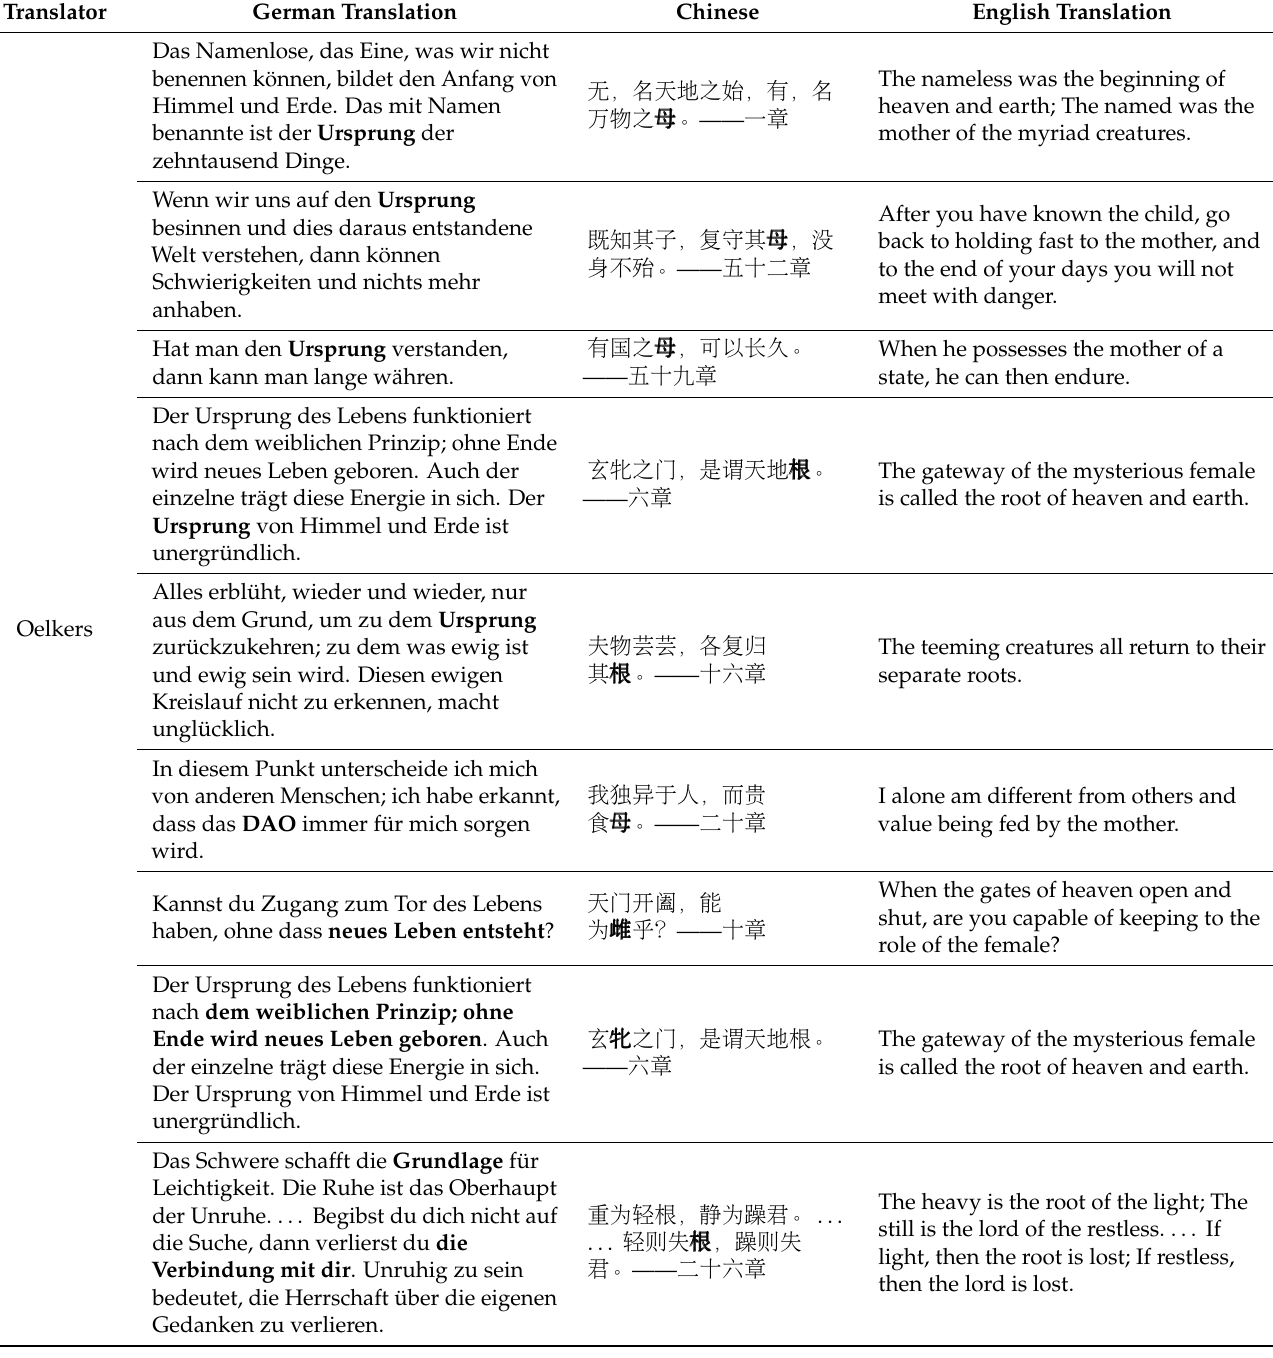
Table 6. The Total Concealment of Xi à ng in the German Translation of the D à o D é J¯ıng . Translator German Translation Chinese English